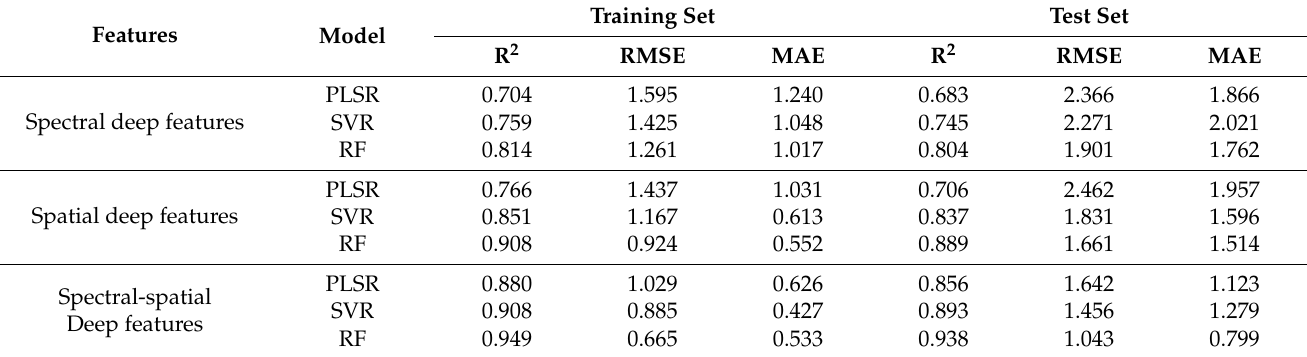
Table 4. Performance comparison of tea polyphenol prediction models based on different